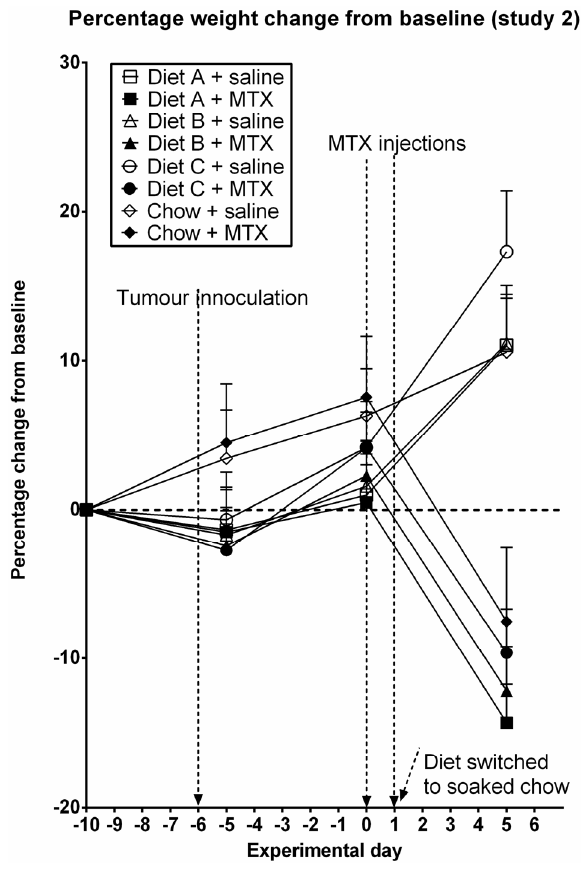
Figure 3. Percentage weight change from starting body weight (study 2) for each individual diet. Data are presented as mean + SEM. Weight was measured daily, however, data points represent weight every five days.